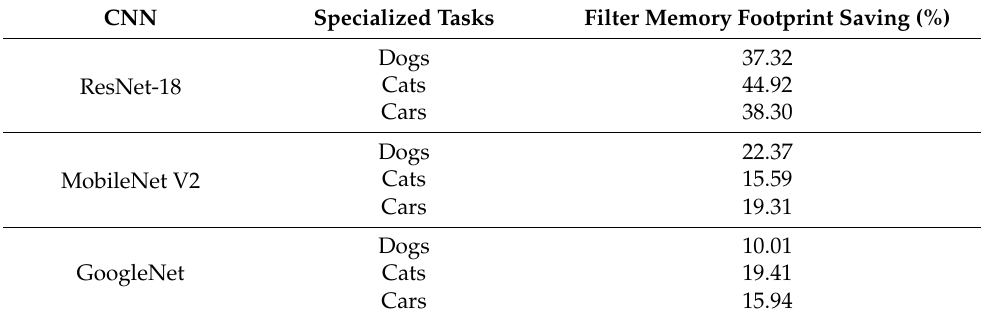
Table 4. Filter Memory Footprint